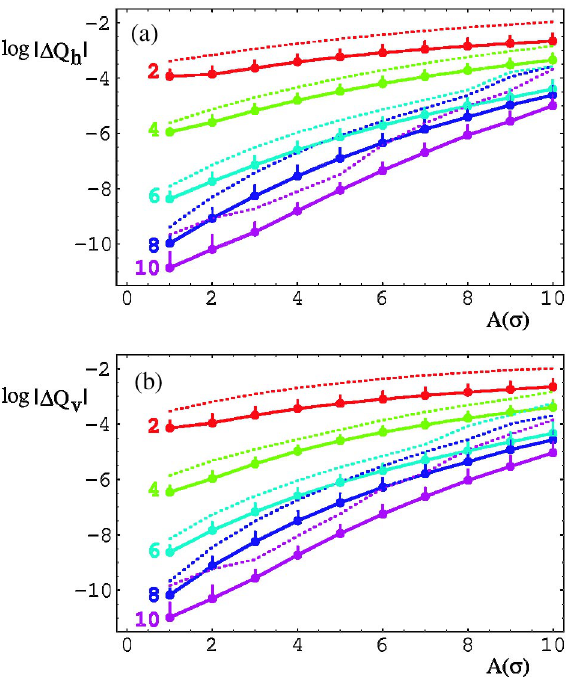
FIG. 4. (Color) Tune error ( log ) versus amplitude, parame- 10 trized by Cremona map order. The upper and lower plots correspond to the horizontal and vertical planes. The solid and dashed lines show, respectively, the average and maximum (over 60 seeds and five angles) of the absolute difference in tunes measured from tracking results based on direct and Cremona map tracking.